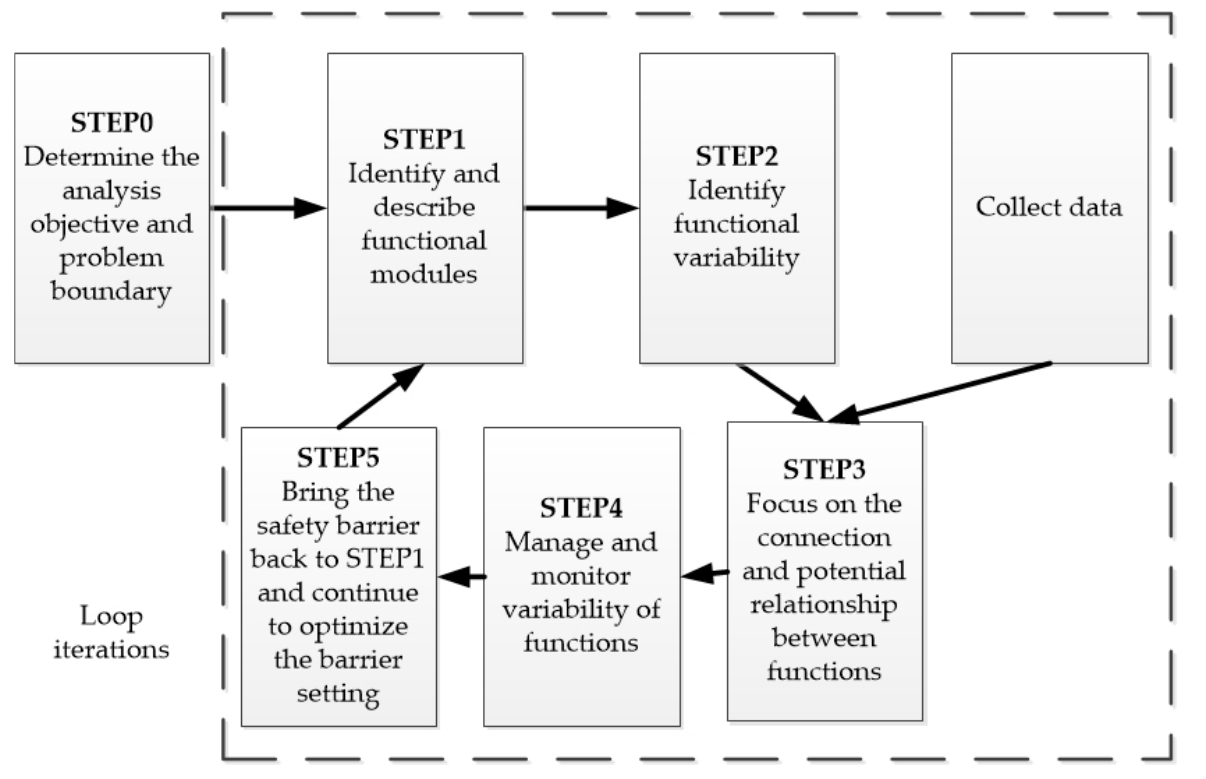
Figure 3. Improved FRAM analysis process.